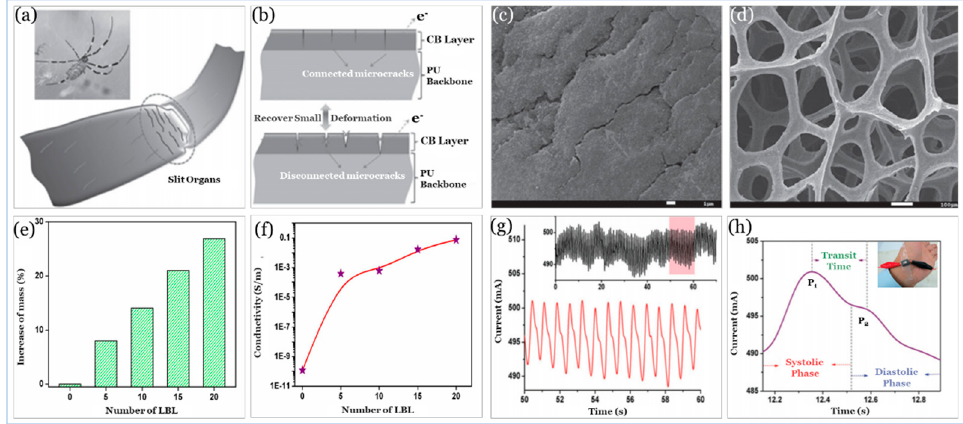
Figure 11. CB@PU Sponge. Reproduced with permission [240] Copyright 2016, Wiley. ( a ) Sketch of the crack-shaped slit organs near the leg joints of the spider. ( b ) SEM images of the microcrack junctions on a CB@PU sponge after compressing pre-treatment. ( c ) SEM images of an uncompressed CB@PU Sponge. ( d ) Comparison of mechanical properties of CB@PU Sponges with di ff erent Layer By Layer (LBL) deposition cycles of CB, a relative increase of CB mass on PU Sponges, ( e ) and an increase in conductivity of CB@PU Sponges. ( f ) with di ff erent LBL deposition cycles of CB. ( g ) Original signal of current curves for wrist pulse monitoring. ( h ) Zoomed waveform extracted from the original signal, showing some critical features that are essential for health